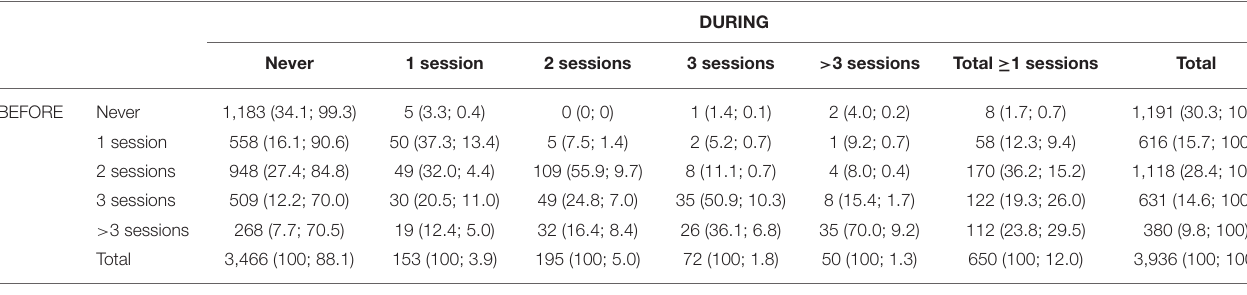
TABLE 6 | Contingency table for comparison of frequency (category percentages for during; category percentages for before) of duration of an individual session in sports clubs before and during lockdown.